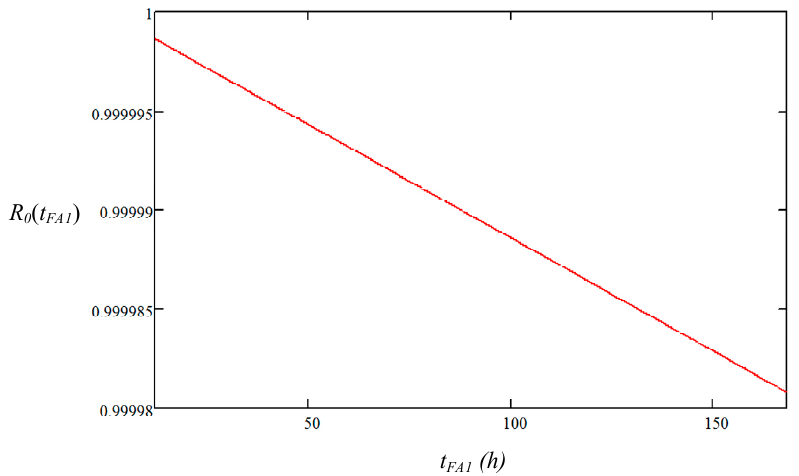
Figure 3. The probability dependence of PSS in TTD staying in full ability state S FA in the time function of restoring full ability state t FA1 . On the basis of the diagram in Figure 3, the rationalisation of activities connected with restoring a full ability state can be achieved (e.g., maintaining services that guarantee the system repair in a given time).